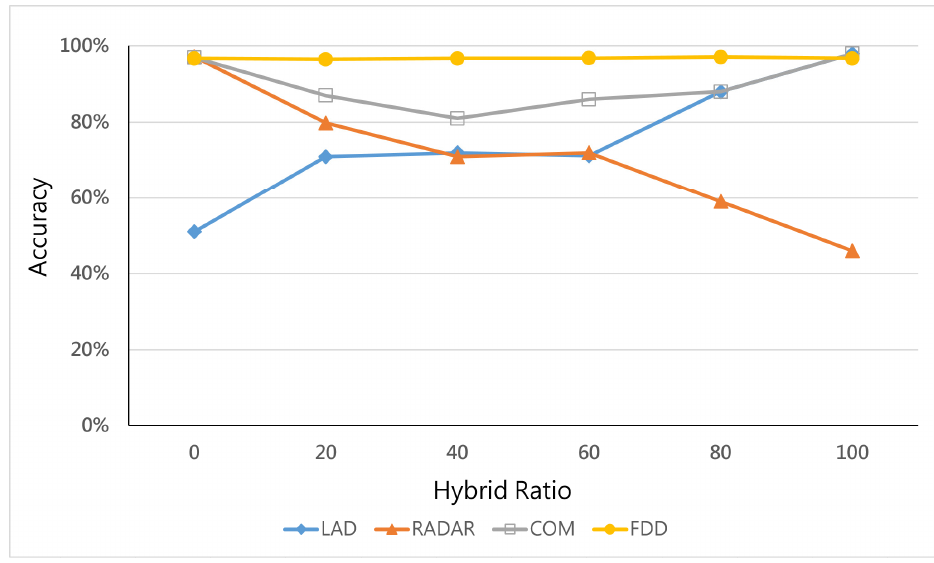
Figure 5. Accuracy vs. hybrid ratio.